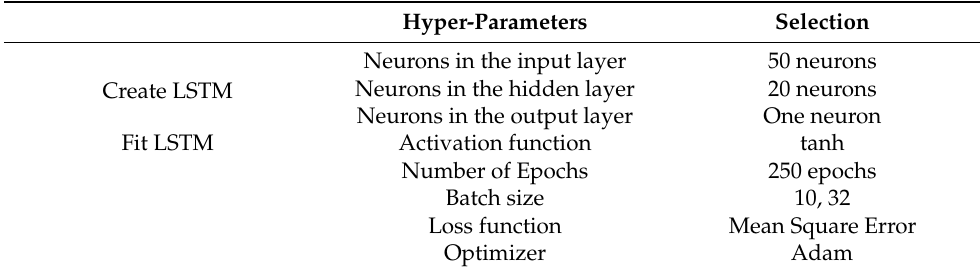
Table 3. Hyper-parameters used for training LSTM network. Hyper-Parameters Selection Neurons in the input layer 50 neurons Neurons in the hidden layer 20 neurons Create LSTM Neurons in the output layer One neuron Fit LSTM Activation function tanh Number of Epochs 250 epochs Batch size 10, 32 Loss function Mean Square Error Optimizer